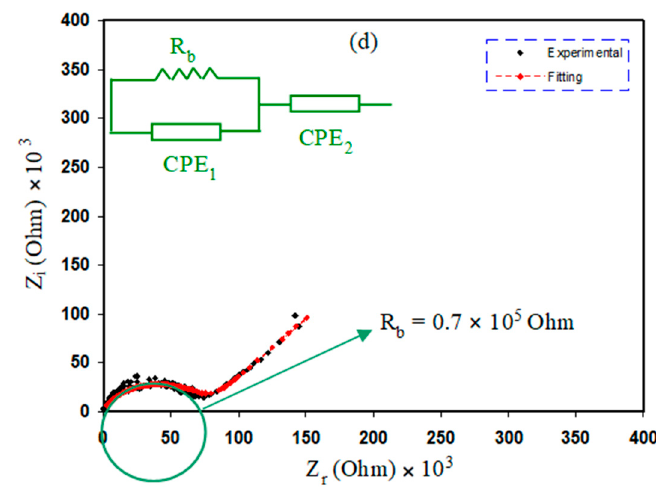
Figure 4. Electrical impedance plots for ( a ) CSPEH1, ( b ) CSPEH2, ( c ) CSPEH3 and ( d ) CSPEH4 polymer blend electrolytes. Table 4. Relation between DC ionic conductivity and lattice energy of different ammonium salts.